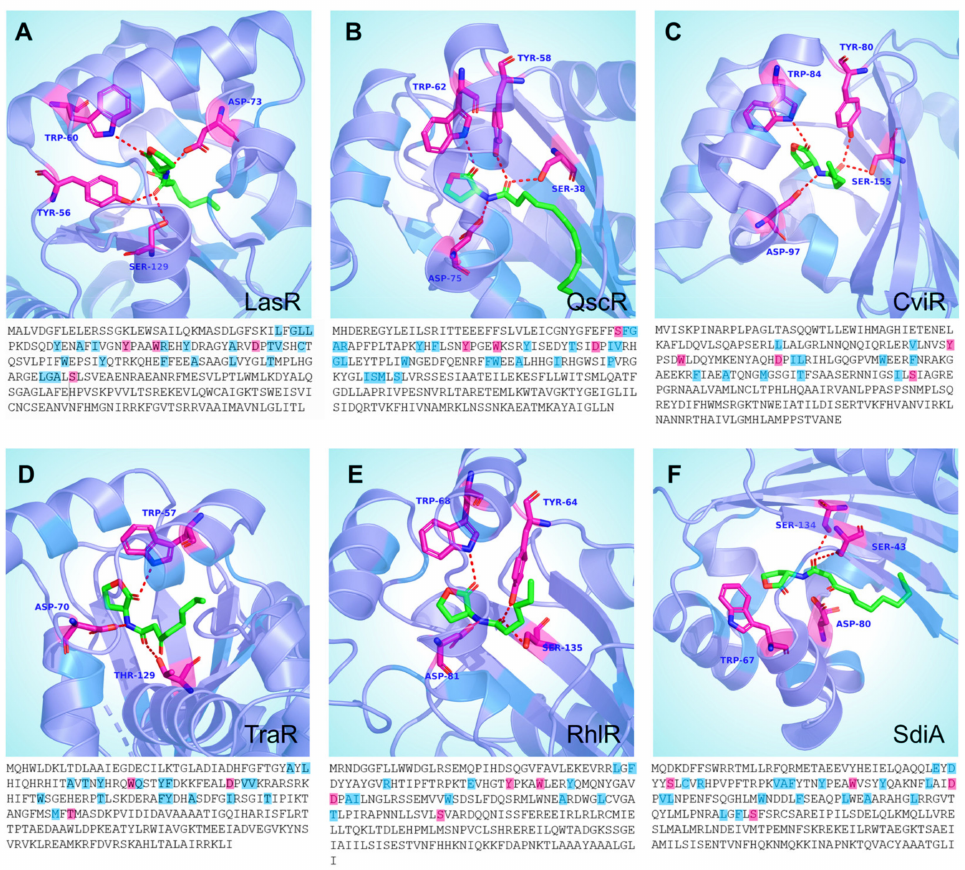
Figure 6. Ligand-binding site analysis of quorum-sensing regulators. The representation of cartoon sticks shows the contact residues of the ligand-binding site and the FASTA sequence highlighting the residues involved in ligand interactions (magenta: the h-bond-forming residues, blue: the residues within 5A of the ligand). The receptors are highlighted in slate: ( A ) LasR, ( B ) QscR, ( C ) CviR, ( D ) TraR, ( E ) RhlR, and ( F )